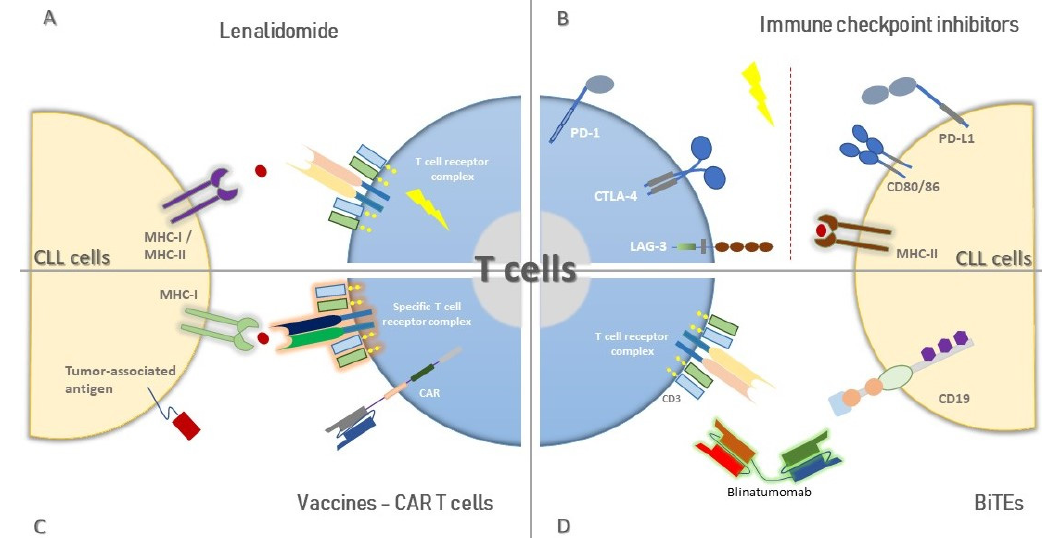
Figure 1. Mobilization of T cell functions through immunotherapy. The T cell compartment in CLL displays a great variety of defects leading progressively to immunosuppression; however, immunotherapy could restore T cell function through distinct ways. ( A ): Lenalidomide treatment increases T cell activation, amongst other effects; ( B ): IMiDs restrain inhibitory signaling mediated by overexpressed ligands and receptors in T cells and CLL cells, respectively; ( C ): Vaccine and CAR-T cell design based on the identification of TAAs could reinvigorate T-cell-mediated immunity; ( D ): BiTEs stimulate and drive cytotoxic T cell responses against specific molecules expressed by CLL